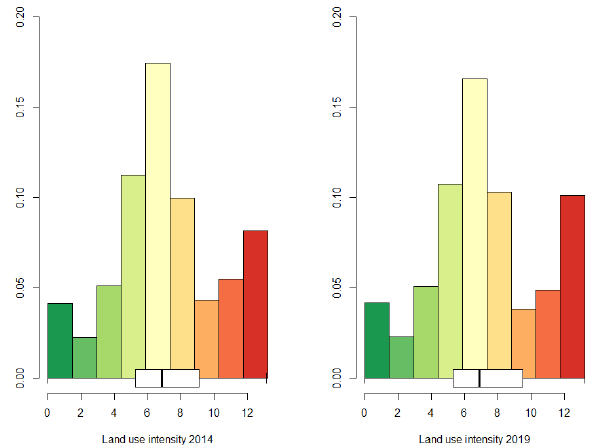
Figure 10. Changes in the LUI index values for 100 m × 100 m pixels in the Trondheim municipality (321.8 km 2 ) from 2014 (left) to 2019.